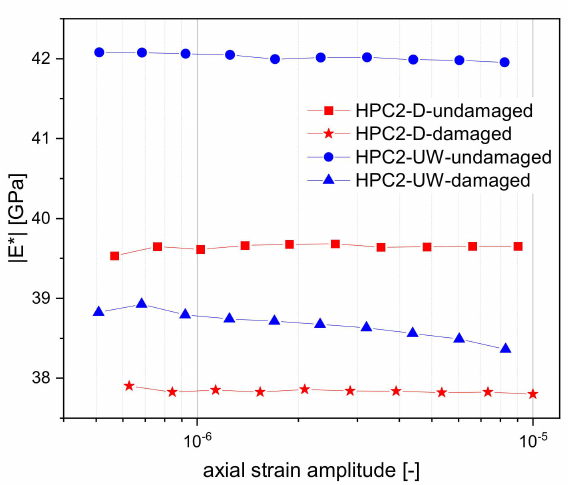
Figure 9. Frequency-dependent Young’s modulus (average of three): HPC2-UW ( left ); HPC2-D ( right ).